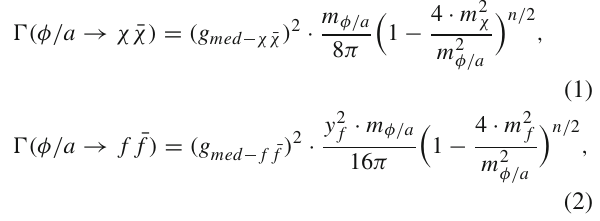
Fig. 2 Branching Ratio for the decay of a spin-0 mediator to a pair of t ¯ t , assuming interactions with dark matterand tops only. The Branching Ratioispresentedforascalar(up)andpseudo-scalar(bottom)scenarios. The diagonal black dashed lines present the limit in the parameter